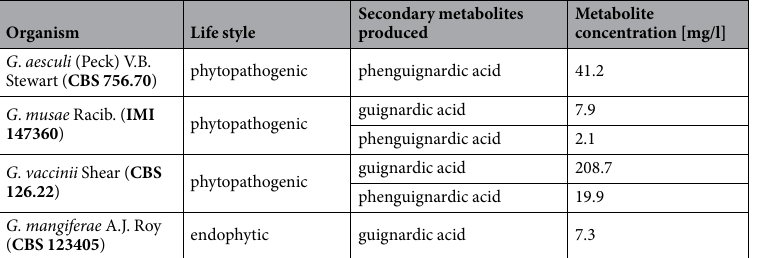
Table 1. Guignardia species examined and the phytotoxic dioxolanones identified. G. aesculi , G. musae , G. vaccinii and G. mangiferae were cultivated by submerged fermentation and analysed for the production of secondary metabolites. Metabolite concentrations are given in mg/l culture.